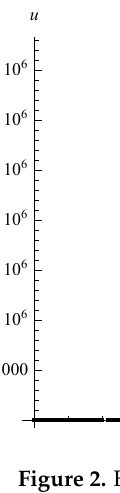
for various initial values. 2 t